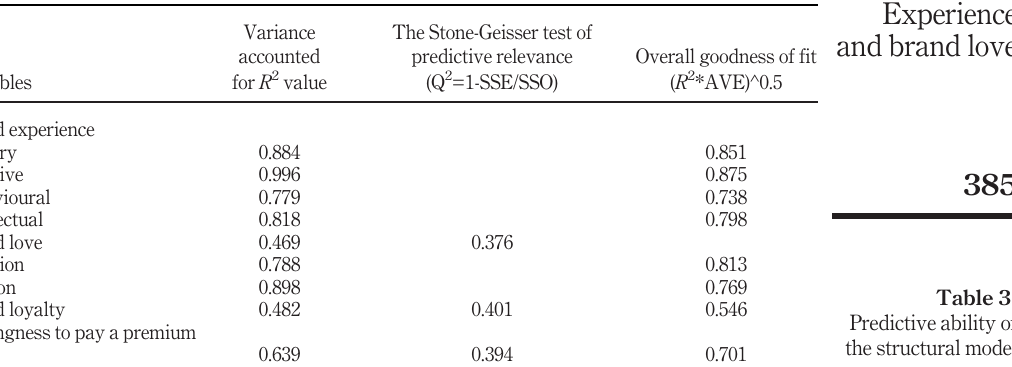
Table 3. Predictive ability